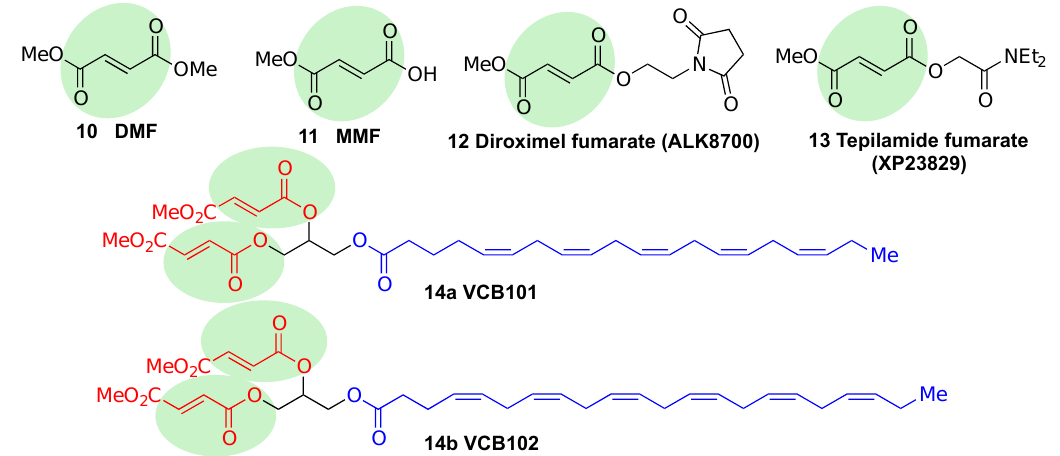
Figure 9. Chemical structures of fumaric acid ester derivatives. Their electrophilic moieties are highlighted in green.